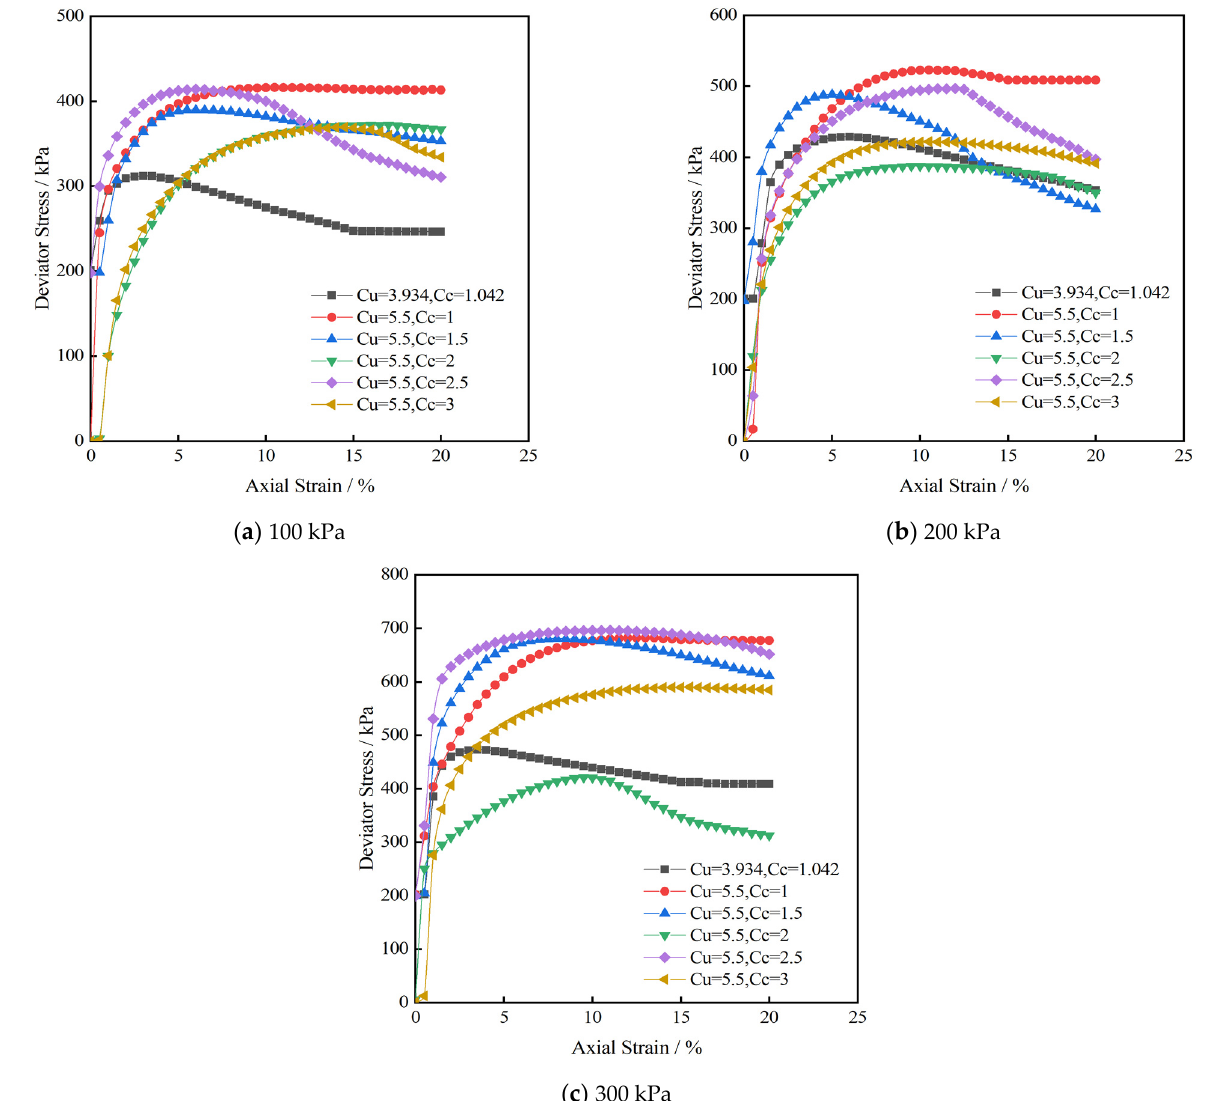
Figure 13. Stress–strain curves of tailings sand corresponding to different C c .